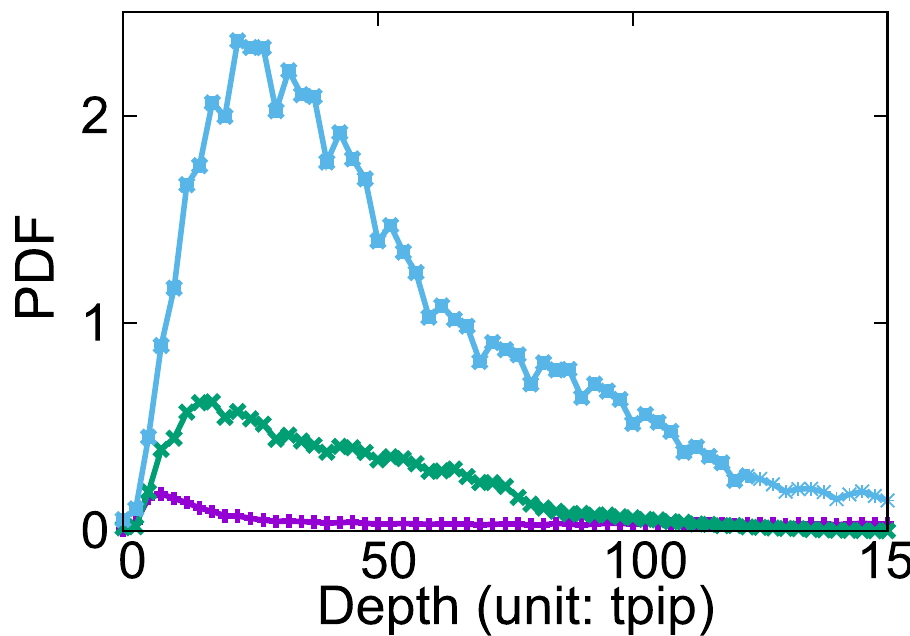
Fig 6. Order-book depth distributions for the banks classified according to their used strategy: Economically- motivated (EM), arbitrage-motivated (AM), and market makers (MM) strategies are represented by violet, green, and light-blue lines, respectively. Depth is the distance from the current best price to the limit-order prices submitted by the banks following each strategy. We use an average for both the bid and ask sides.